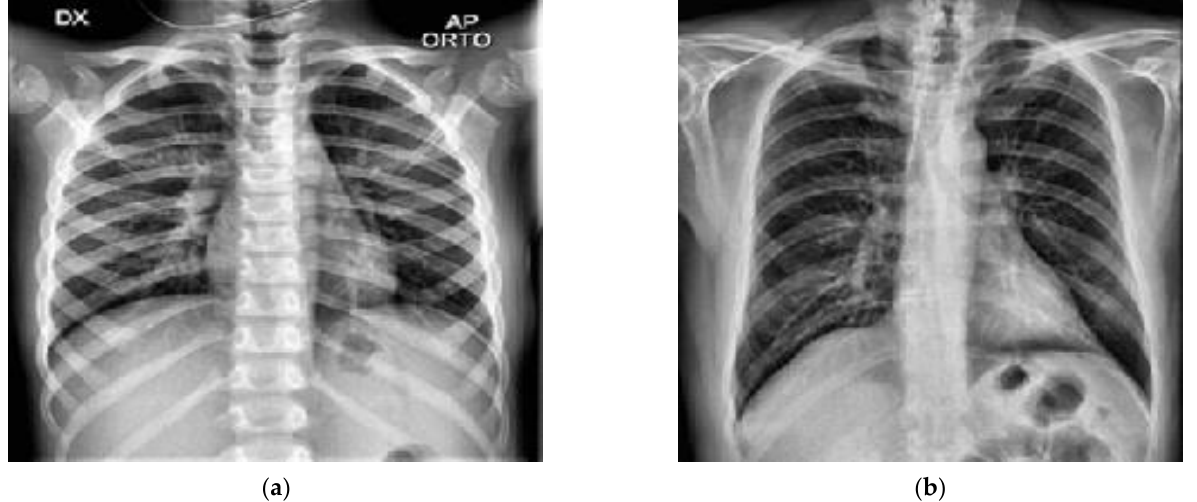
Figure 1. Chest X-ray image data samples. ( a ) Healthy; ( b ) COVID-19.